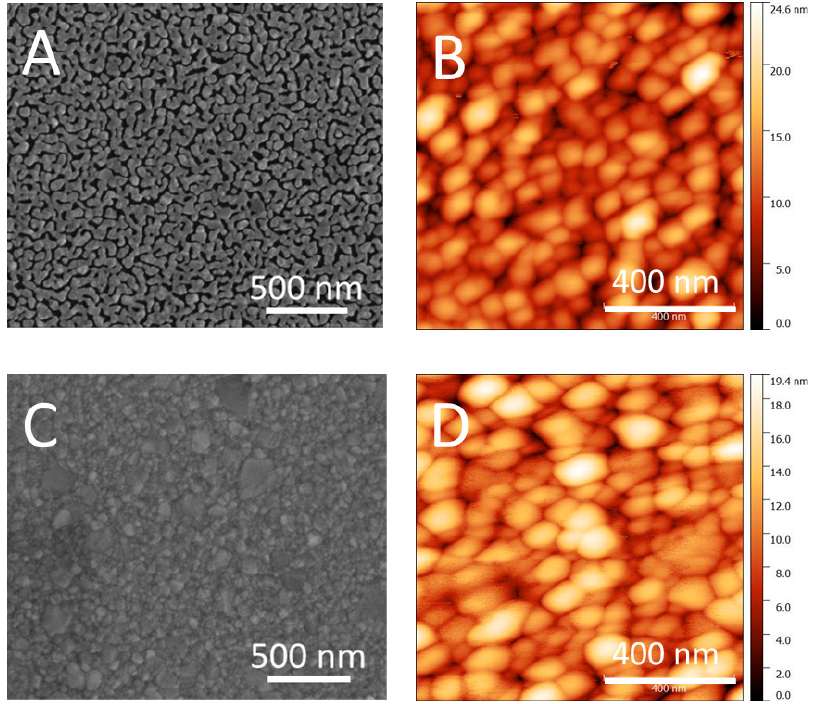
Figure 5. SEM and topological AFM images of SiO 2 surfaces upon metallization with 12 nm ( A ) and ( B ) and 77 nm ( C ) and ( D ) of Ag, respectively.